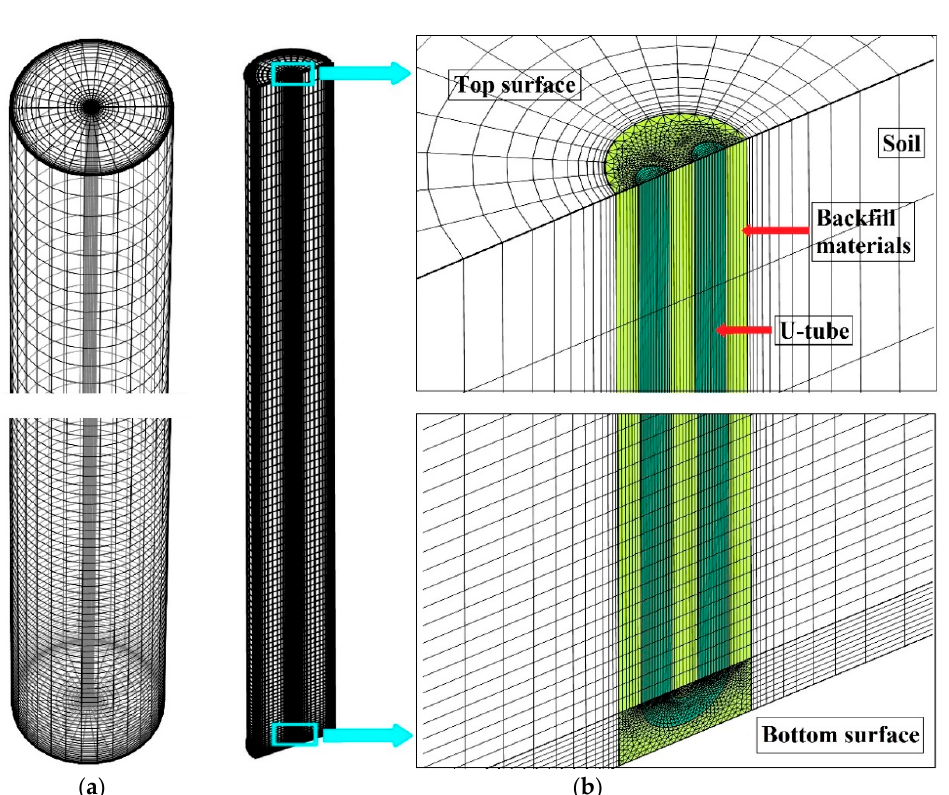
Figure 3. Three-dimensional mesh: ( a ) computational mesh around borehole; ( b ) half of computational domain. Table 3. Grid-independency test of finned U-tube GHEs.